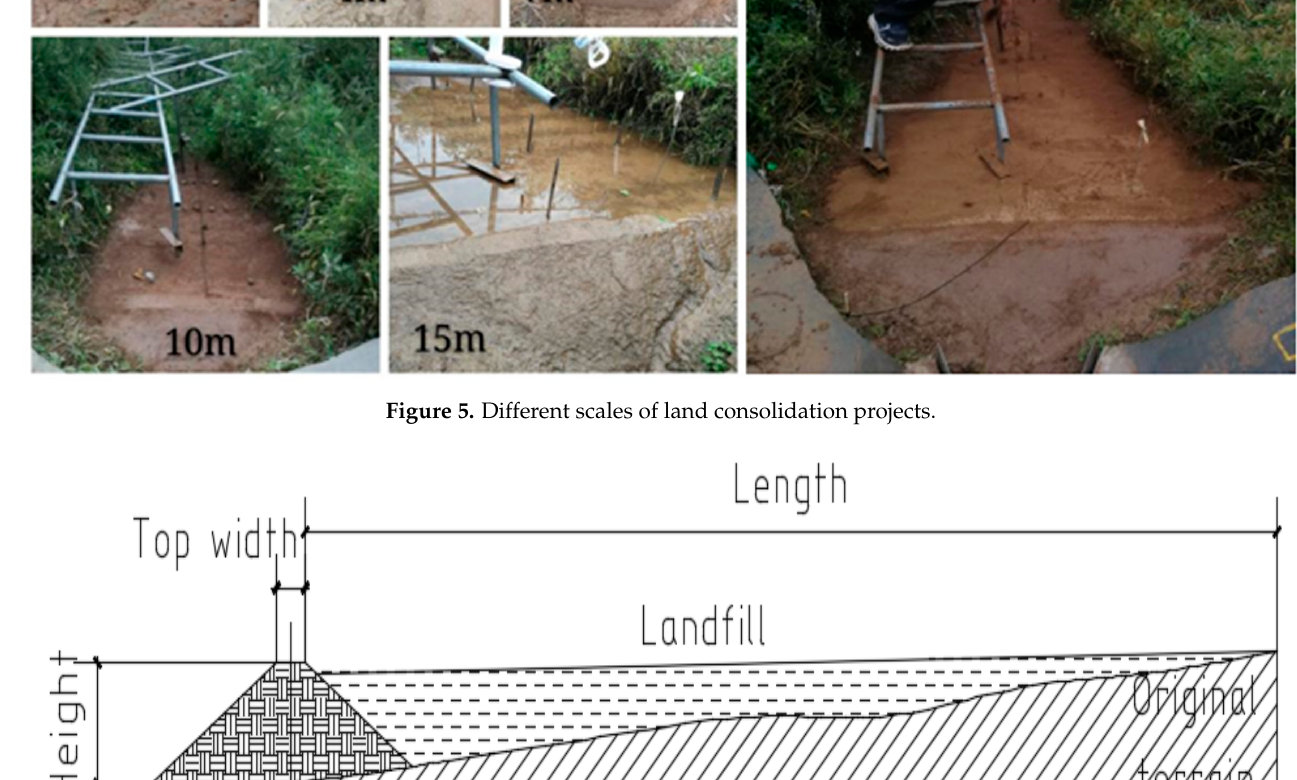
Figure 5. Different scales of land consolidation projects. Table 3. Sectional dimensions of the prototype dam. Dam Height (m)